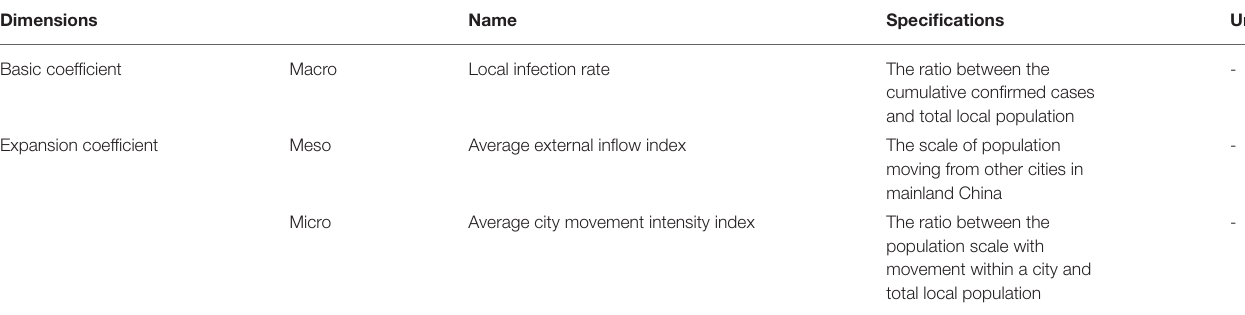
TABLE 1 | Index system for calculation of comprehensive epidemic risk in the BTH area.